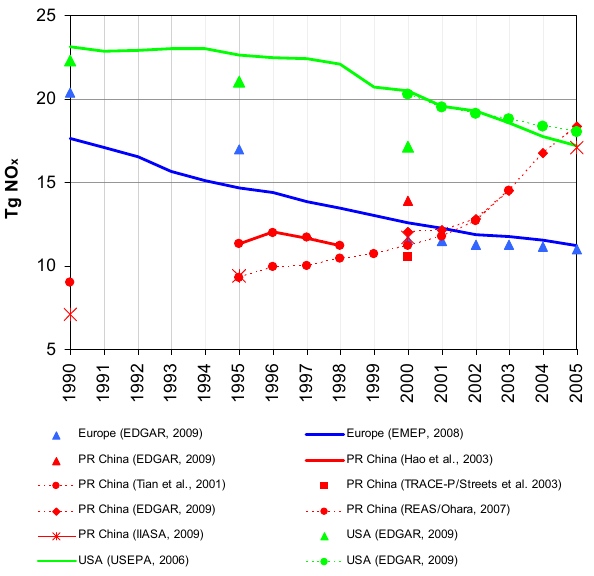
Fig. 10. Estimated trends in N 2 O emissions in Europe, the US and the People’s Republic of China for the period 1990-2005. The observed break in trend for EDGAR 2009 arises from differences between EDGAR v4 (2000 onwards) and EDGAR 32/EDGAR Hyde 1.3/1.4 for (1990-1995). While there is a consistent upward trend, some natural sources previously included in the analysis have not been included in EDGAR v4; For further detail, see (EDGAR, 2009) for all EDGAR inventory datasets. For the US, EDGAR Hyde 1.4 indicates a slow increase for the period 1990 to 1995, with 2000 emissions remaining at approximately the same level, while UNFCCC figures remains around 1.25 Tg N 2 O yr -1 until 2000, then shows a slight downward move with an increase again towards 2005. A significant increase of N 2 O emissions from the People’s Republic of China is portrayed in EDGAR Hyde 1.4, but EDGAR FT32 emissions for 2000 are lower than EDGAR Hyde for 1995, and not in the pathway that could be interpolated from the sharp increase of Chinese emissions in the period 1990 to 1995. The GAINS model (IIASA, 2009) contains five-yearly figures for N 2 O, which support the general upward trend, however less steep than by EDGAR Hyde 1.4, with the GAINS value for 2005 being similar to the HYDE 1.5 for 1995 at about 1.8 Tg N 2 O. Due to the small amount of studies available to elicit a